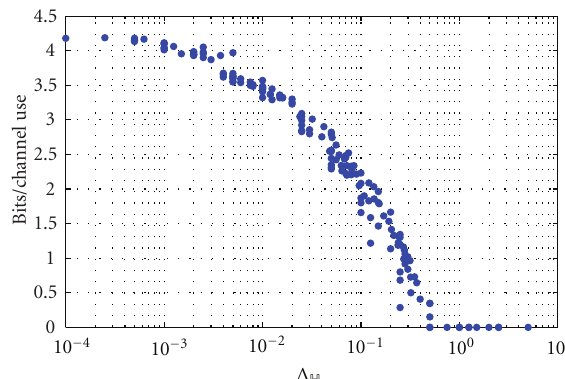
Figure 1: Lower bound (39) as a function of the channel spread factor for a Rayleigh fading channel with a brick-shaped scattering function and white Gaussian Noise. ρ = 15 dB and B = 5